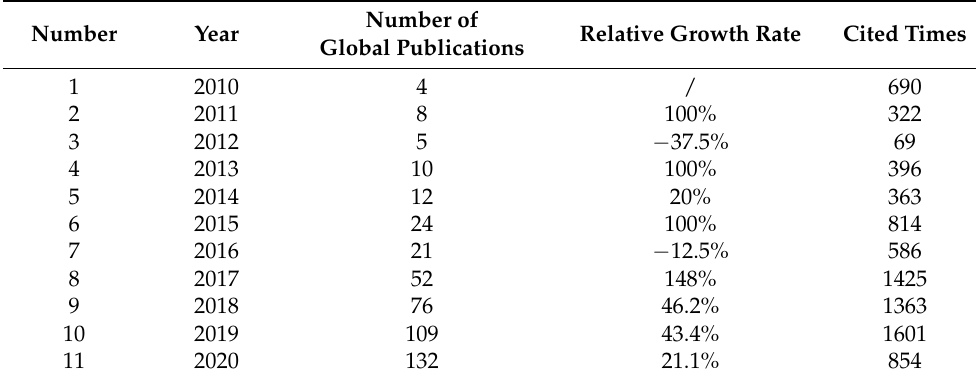
Figure 3. Number of publications and citations globally from 2010 to 2020. Table 1. Analysis of global document volume from 2010 to